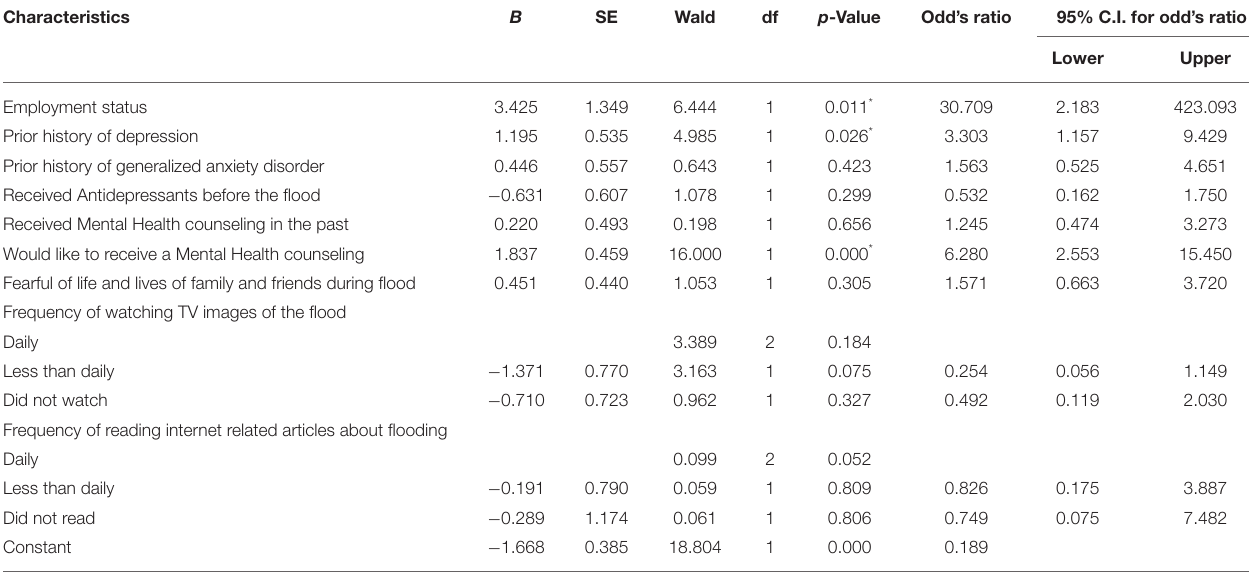
TABLE 6 | Multivariate logistic regression model for respondents’ likelihood to present with moderate to severe anxiety.